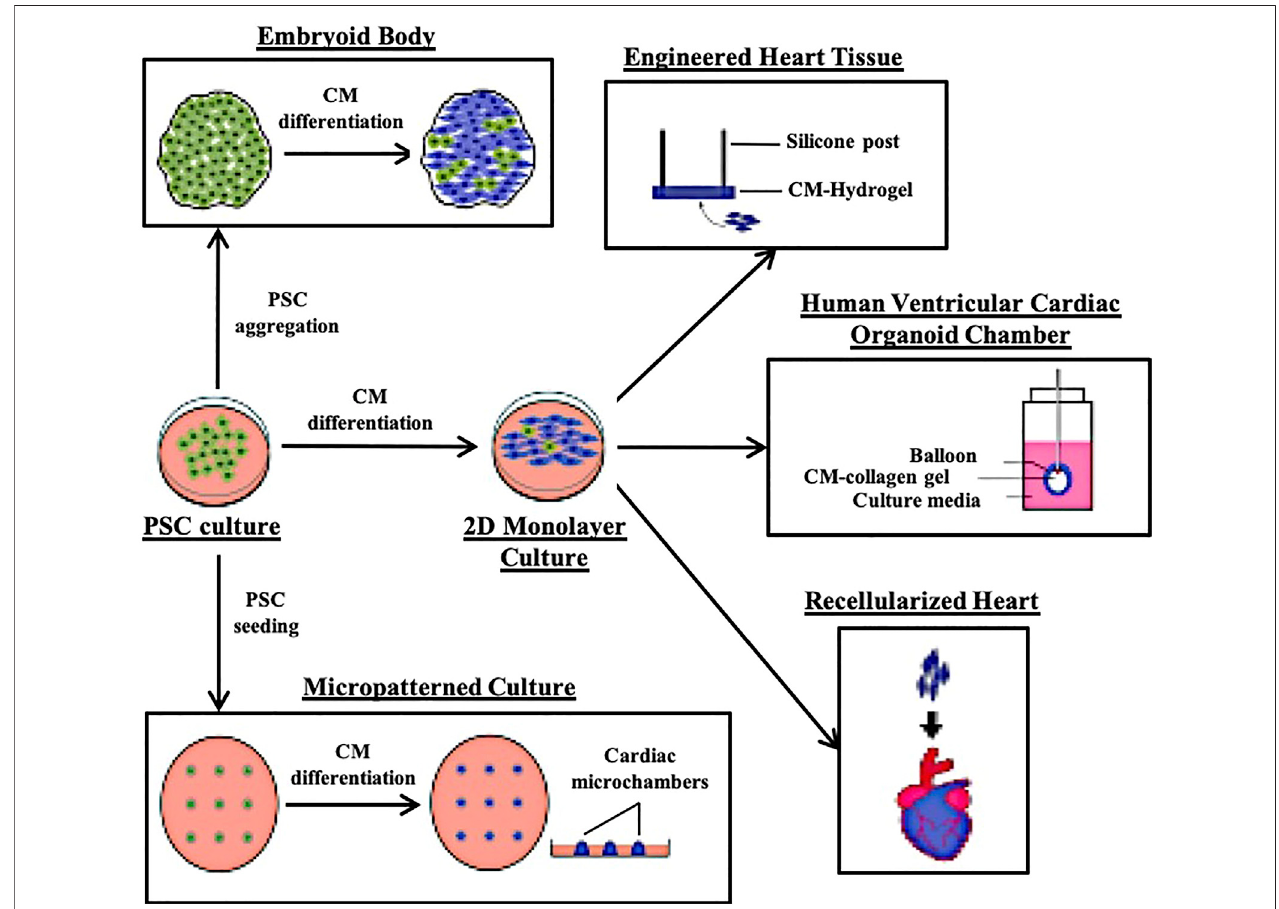
FIGURE 1 | Illustrations of the different 3D cardiac modelling platforms that have been reported.